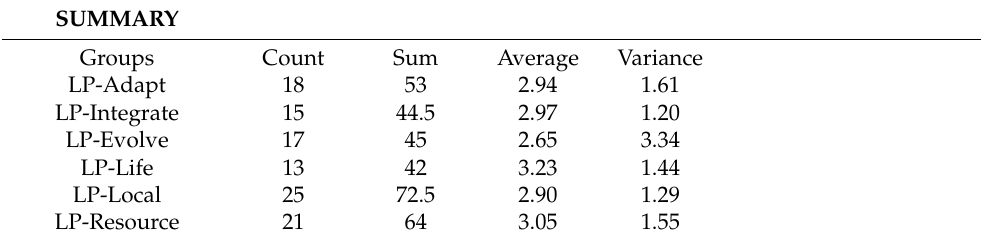
Table 5. Summary table one way ANOVA for